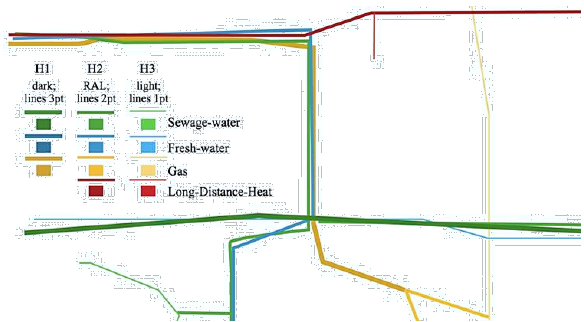
Figure 8. Functional equivalences across networks and